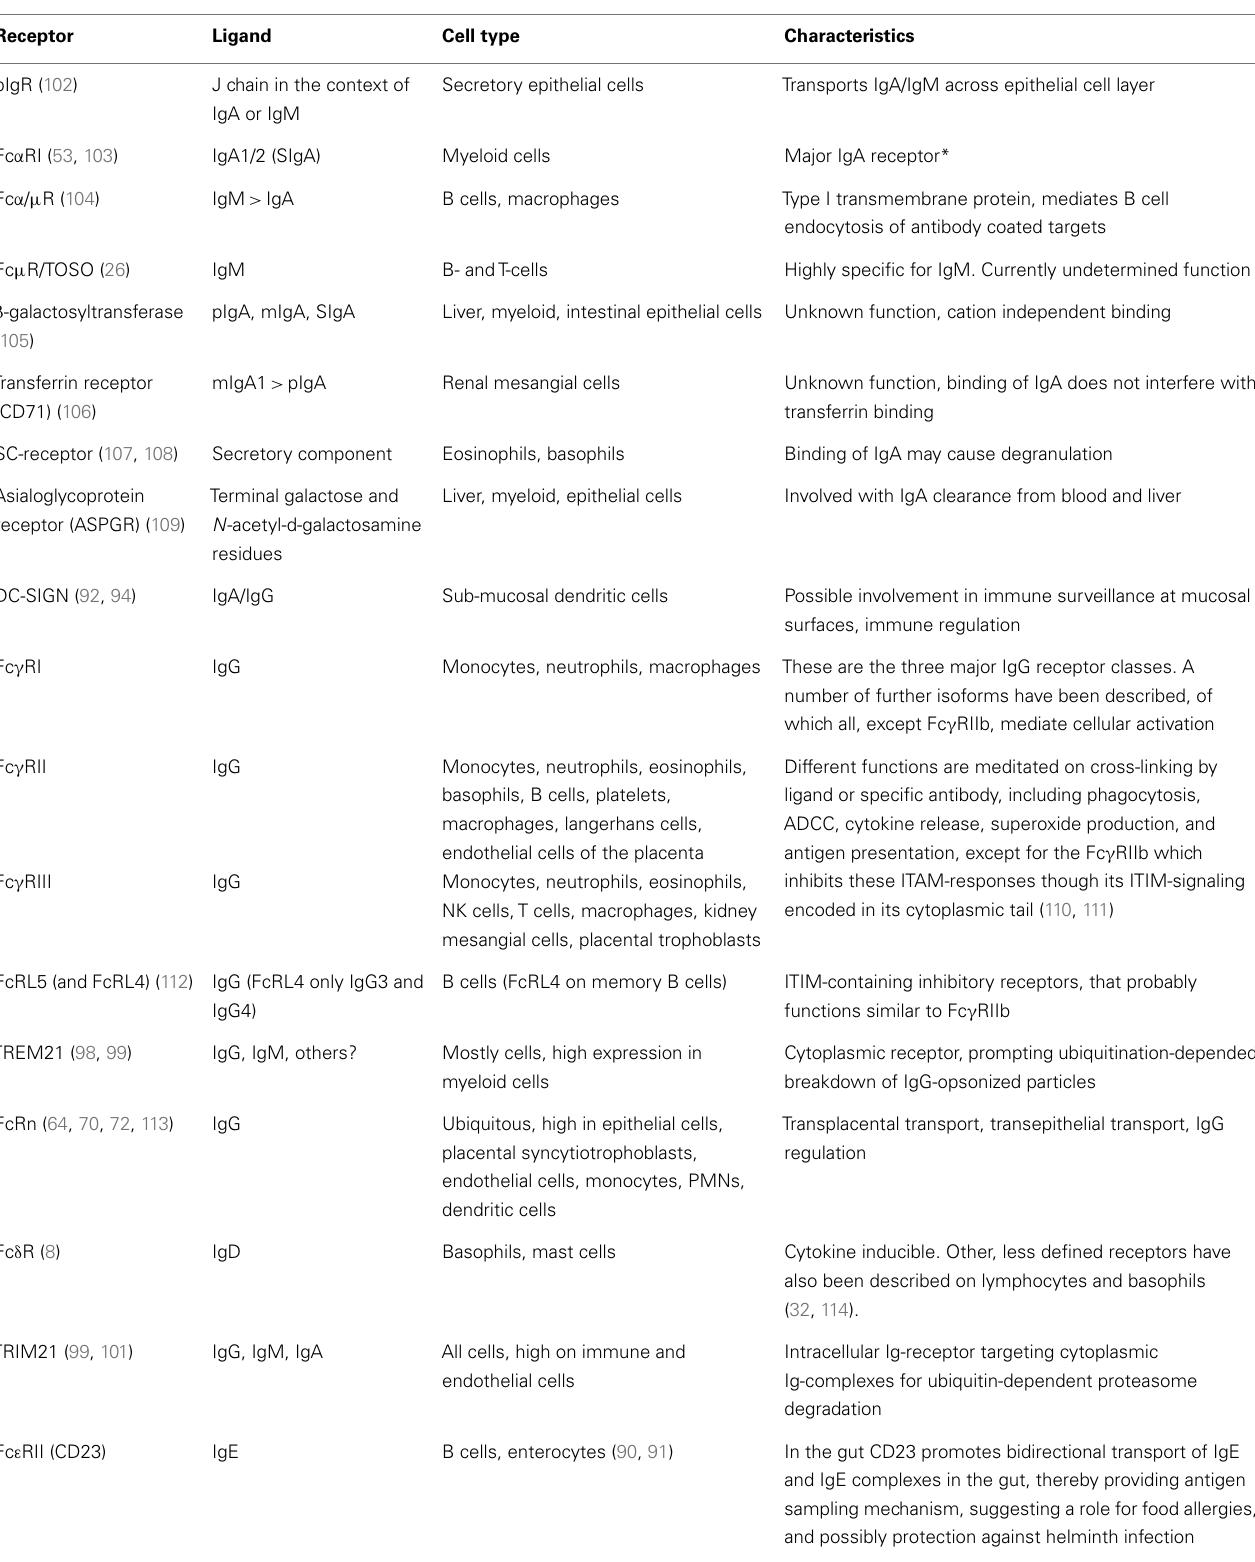
Table 1 | Immunoglobulin receptors involved in transport and/or functions of effector cells or molecules at epithelial surfaces.